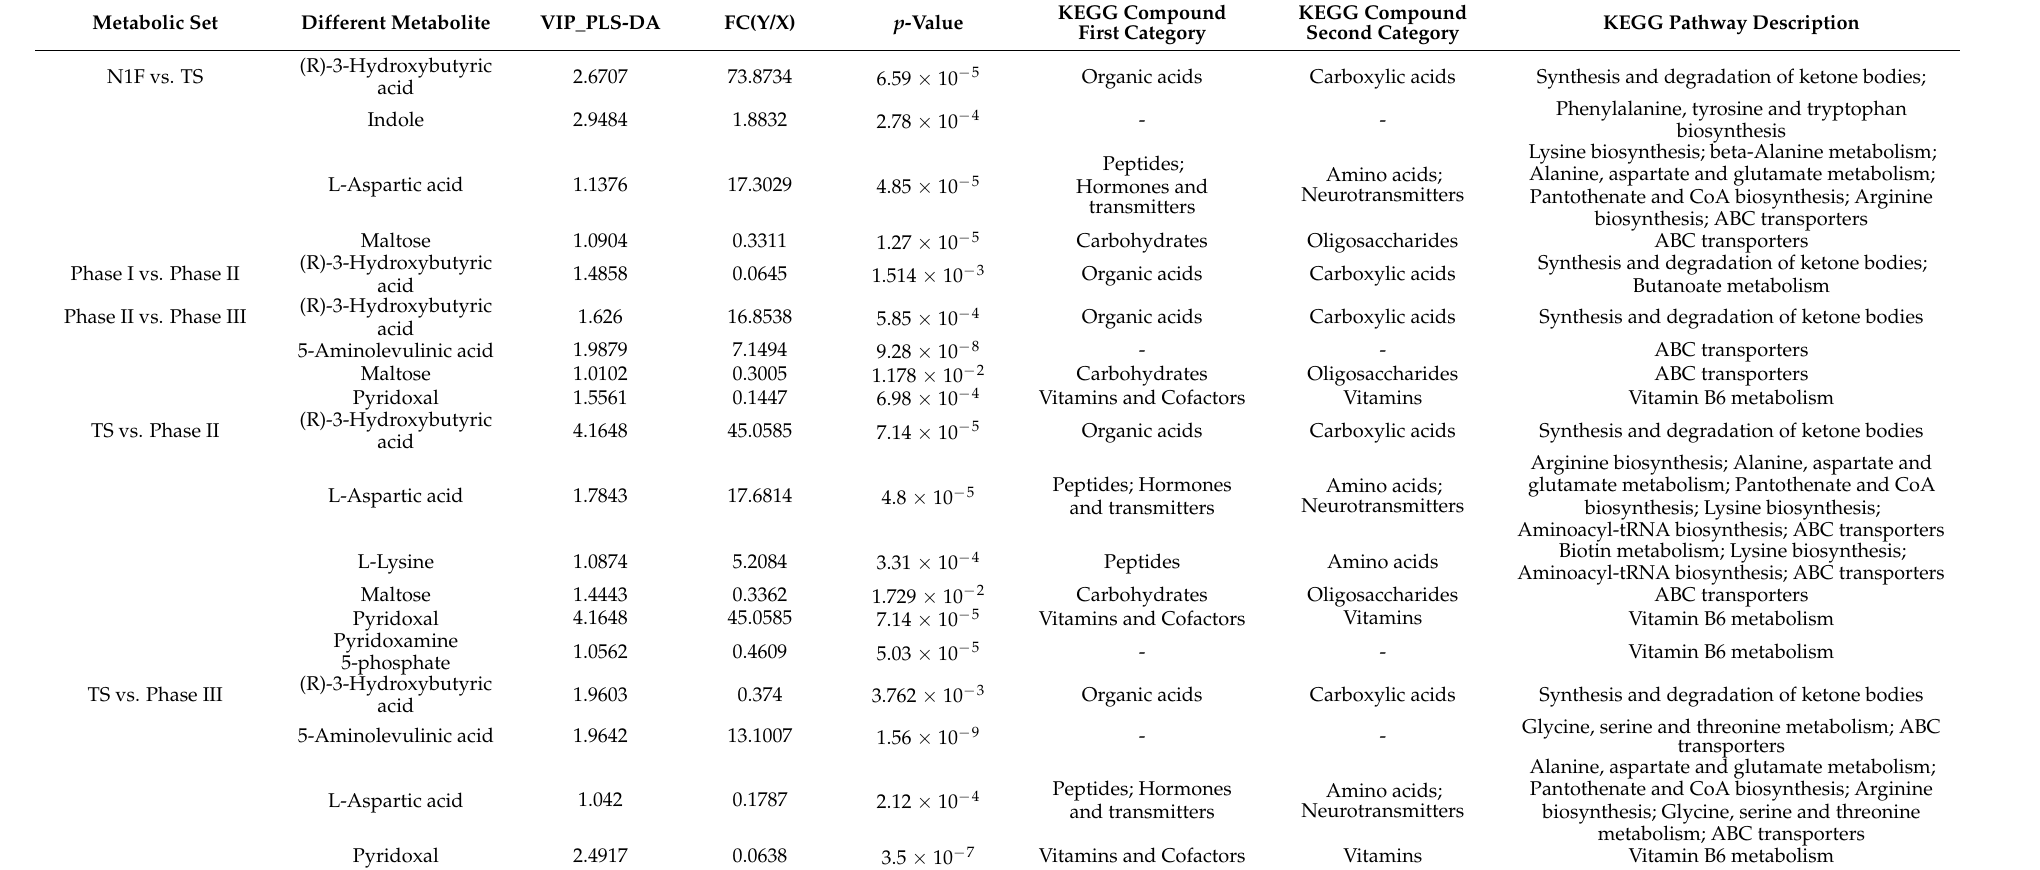
Table 2. Significantly enriched pathways and differential